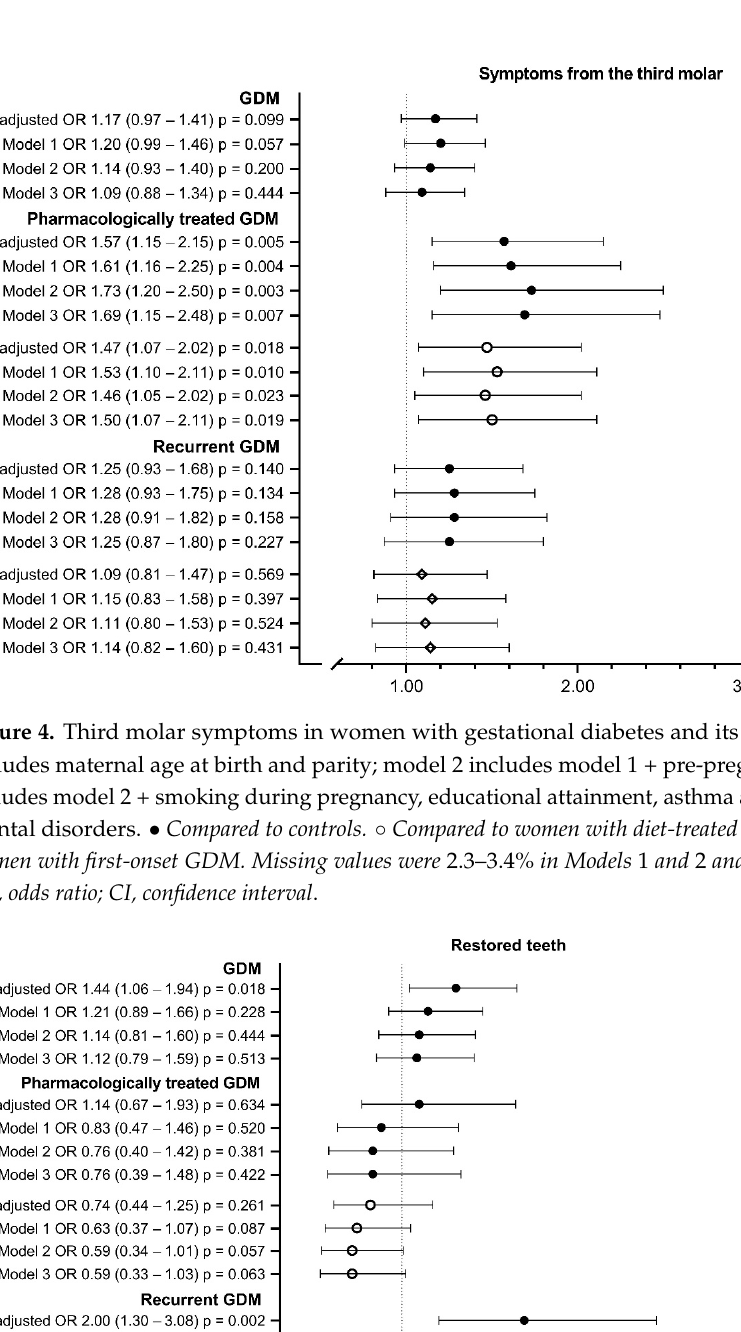
Figure 3. Removal of third molar (yes/no) in women with gestational diabetes. Model 1 includes maternal age at delivery and parity; Model 2 includes Model 1 + pre-pregnancy BMI; Model 3 includes Model 2 + smoking during pregnancy, educational attainment, asthma and insomnia and/or mental disorders. ● Compared to controls. ◦ Compared to women with diet-treated GDM. ◊ Compared to women with first-onset GDM. Missing values were 1.1–1.4% in Models 1 and 2 and 5.7–7.3% in Model 3. OR, odds ratio; CI, confidence interval.